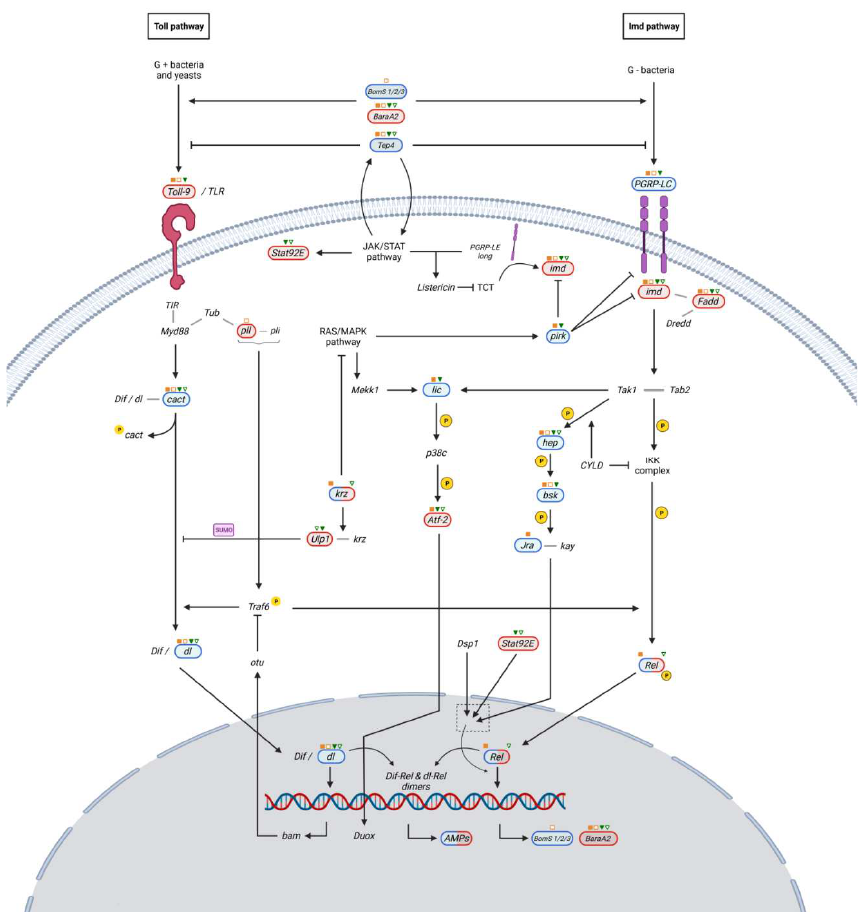
Figure 5. Biochemical model of interactions of Toll and Imd pathways in D. melanogaster as a response to microbial infection. The immune response in D. melanogaster involves the activation or inhibition of multiple pathways, such as RAS/MAPK, JNK, or JAK/STAT. The observed expression change corresponding to the experiment conditions and mutants is shown in blue (upregulation) or red (downregulation). With orange-filled or orange-bordered squares, we indicate that the respective gene significantly varies its expression in infected and uninfected γ COP 14a / γ COP 14a males. With green-filled or green-bordered triangles we indicate a gene that significantly varies its expression in infected and, respectively, uninfected γ COP S057302 /TM6B males. Unmarked components of the pathway did not show any statistically significant expression change. Created with BioRender.com (accessed on 24 February